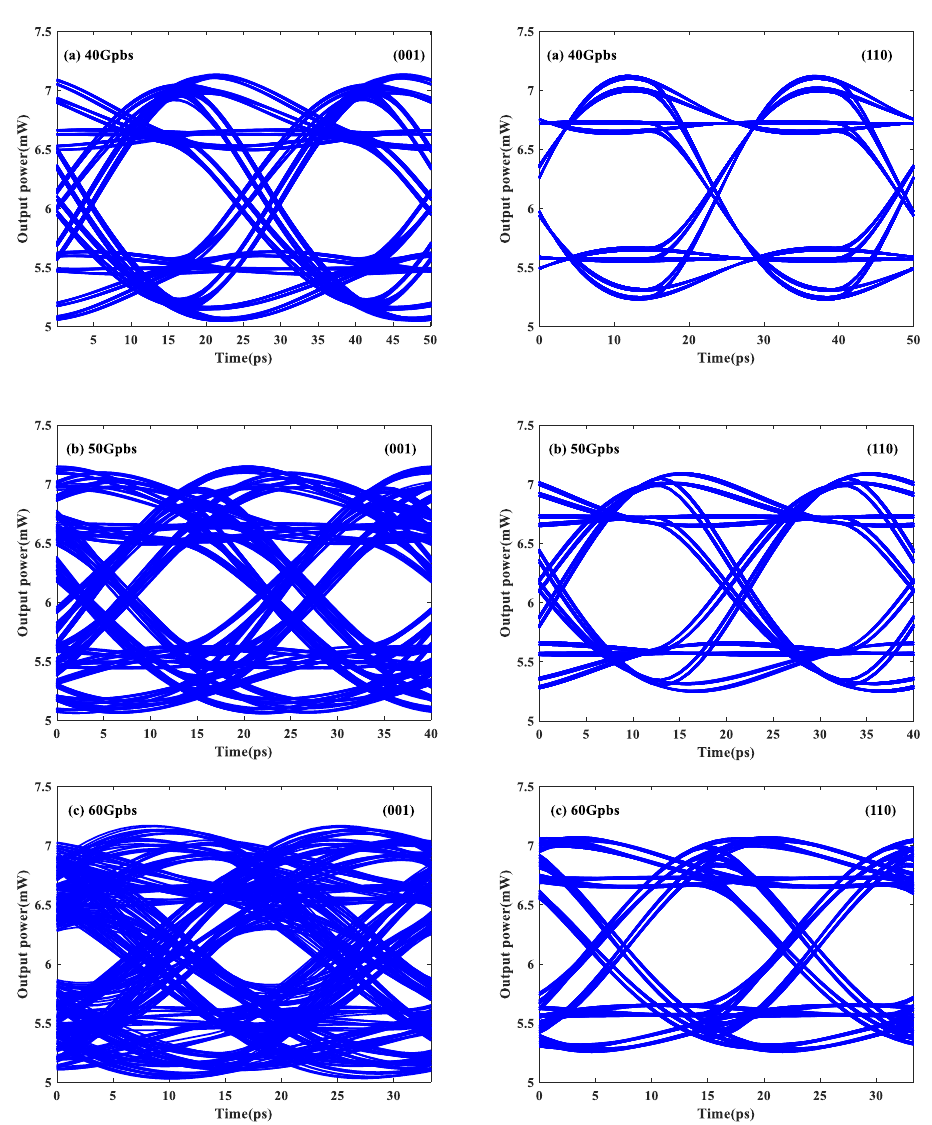
Figure 11. Eye diagrams of (001) and (110) crystal orientations VCSELs for different data rates of ( a ) 40 Gbps, ( b )50 Gbps and ( c ) 60 Gbps.